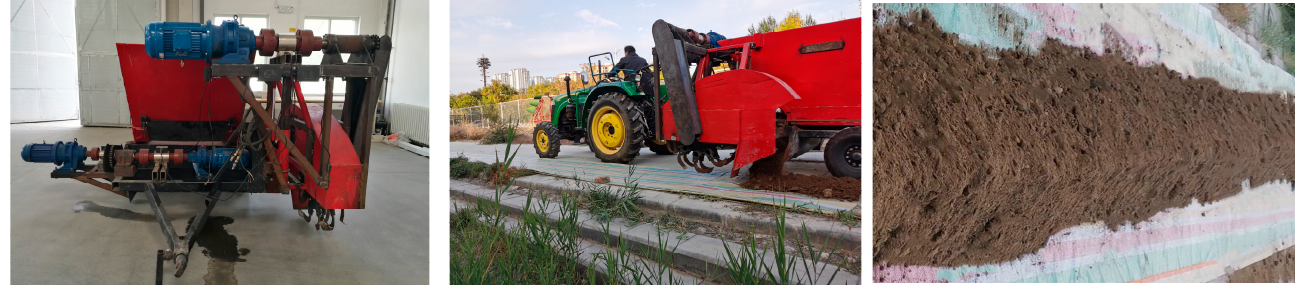
Figure 8. Physical verification test.